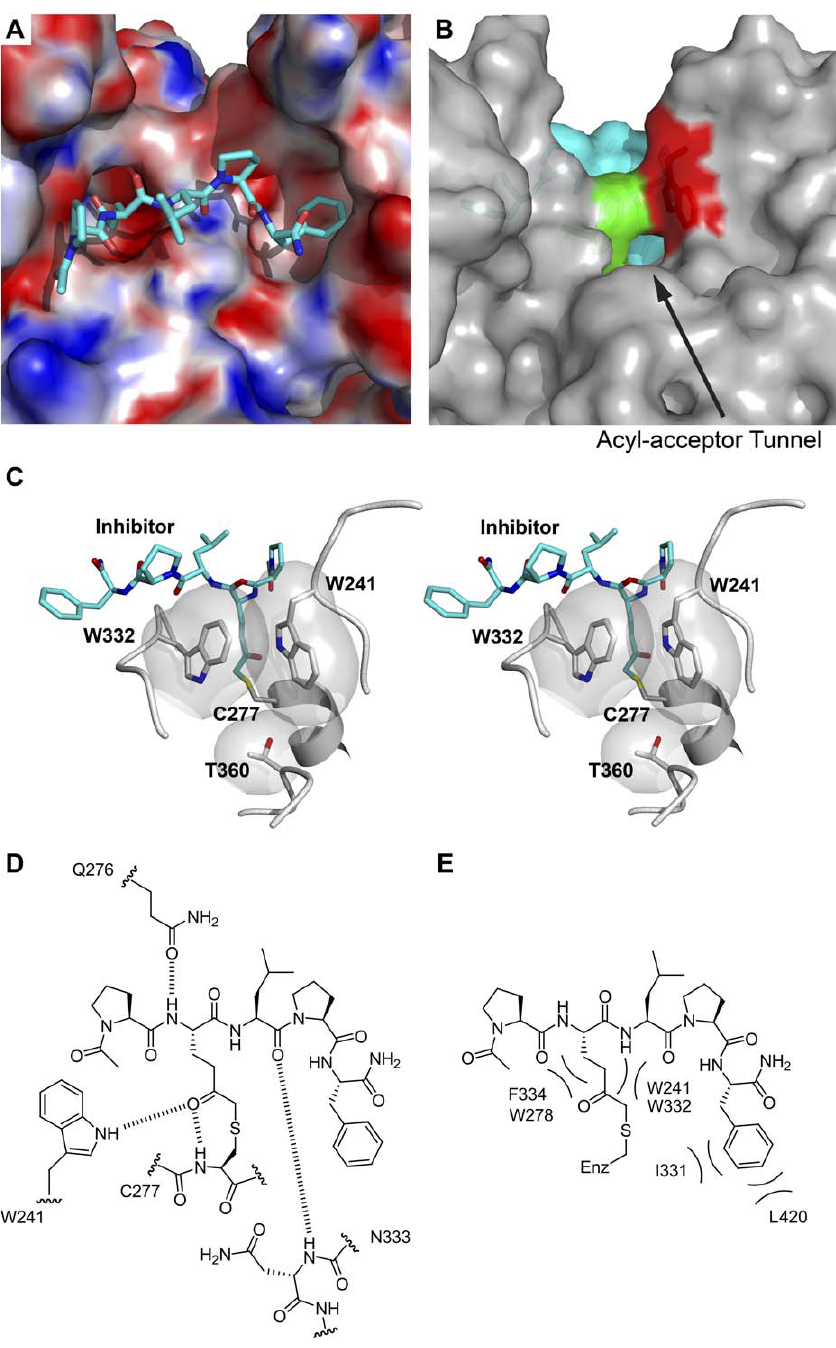
Figure 4. The Active Site of TG2 and Enzyme–Inhibitor Interactions (A) Electrostatic potential surface of TG2 (red indicates negative charge; blue, positive; contoured at (cid:2) 15 k B T to þ 15 k B T) in the vicinity of the peptide inhibitor. (Carbon is indicated by cyan; nitrogen by blue; and oxygen by red.) (B) Surface representation of the active-site tryptophan bridge. W332, W241, and inhibitor are shown in green, red, and cyan, respectively. The proposed acyl-acceptor approach site is indicated. (C) Stereo representation of the active site of TG2. The backbone of TG2 is shown as ribbons. The bridge tryptophans and a T360 that resides in front of the proposed acyl-acceptor entrance are shown as sticks with semitransparent surfaces. It can be seen that the bridging tryptophan residues reside on separate loops above the catalytic Cys (sulfur is indicated by yellow). The thioether attachment of the inhibitor (cyan indicates inhibitor carbons, and gray indicates TG2 carbons) is also evident. (D) Hydrogen-bonding interactions between TG2 and the peptide are shown as dashed lines. (E) Schematic diagram of hydrophobic interactions between TG2 and the inhibitor.